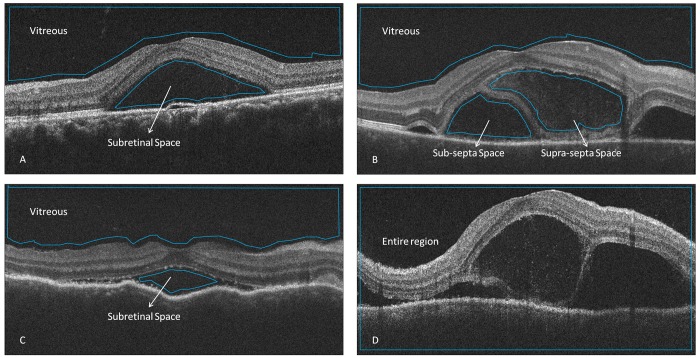
Selection of regions of interest on the optical coherence tomography images of Vogt-Koyanagi-Harada (VKH) disease and central serous chorioretinopathy (CSCR).A. selection of vitreous and subretinal space in CSCR; B. selection of vitreous, supra-septa space and sub-septa space in VKH with subretinal septa; C. selection of vitreous and subretinal space in VKH without subretinal septa; D. selection of entire region.